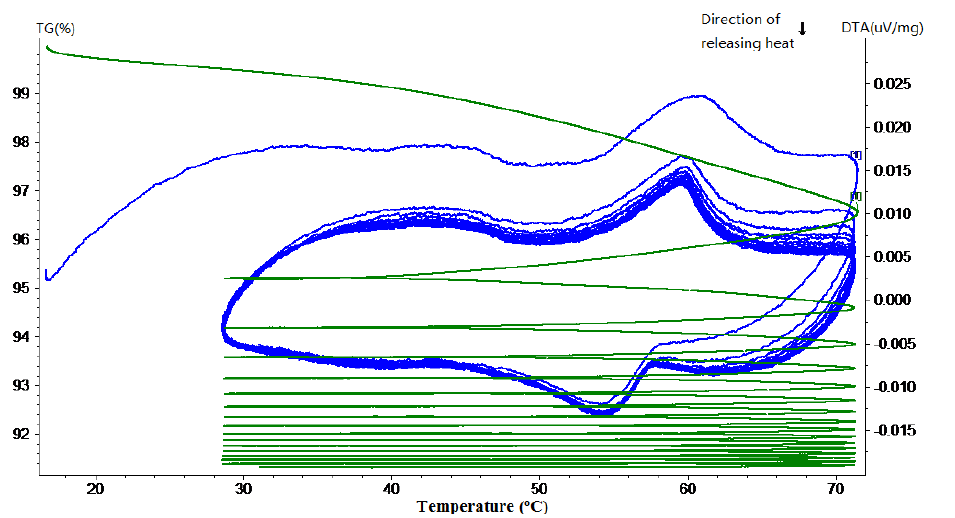
Figure 14. TG-DTA curve of the hardened cement paste specimen with 20% MPCM.